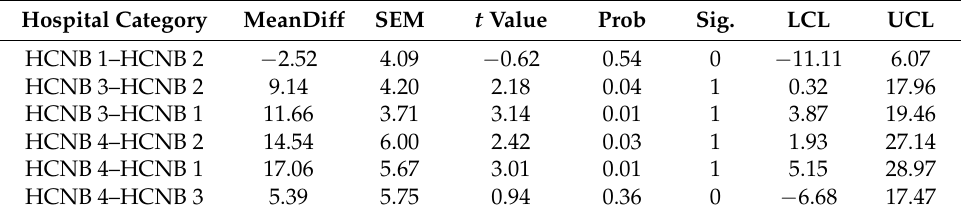
Table 3. Fisher’s test for means comparison with 0.05 of significance